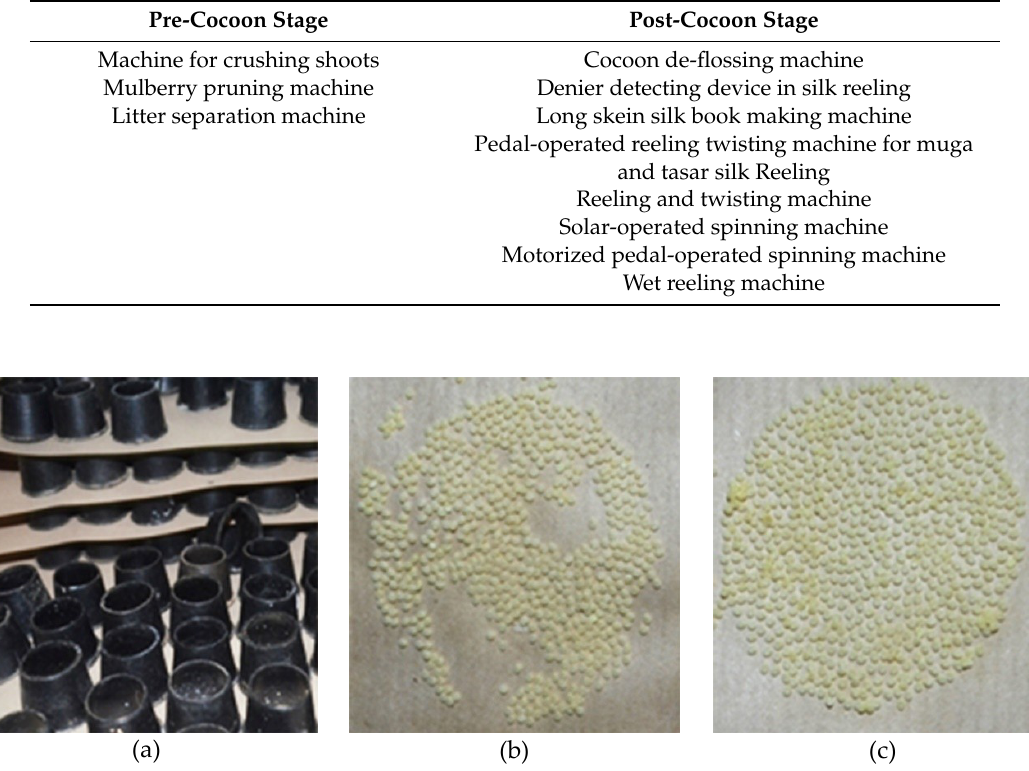
Table 1. Available machinery for pre and post-cocoon stage.